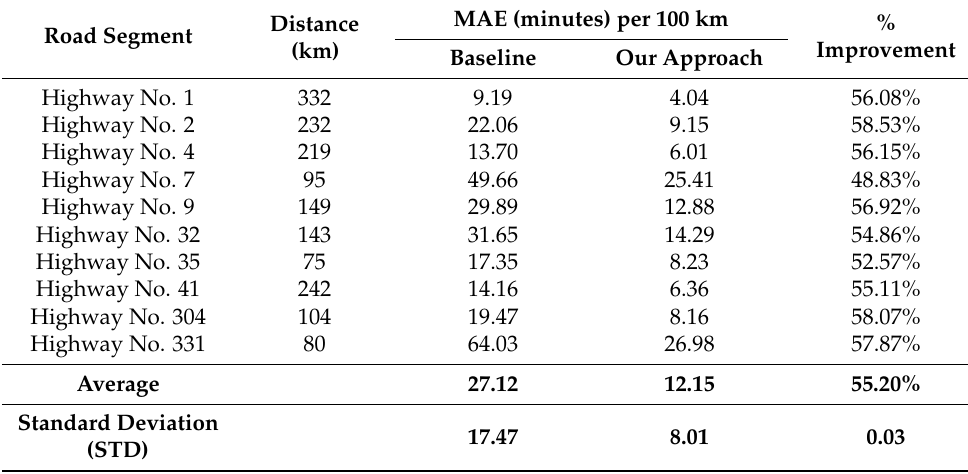
Table 6. A comparison of the baseline and our approach for all road segments.